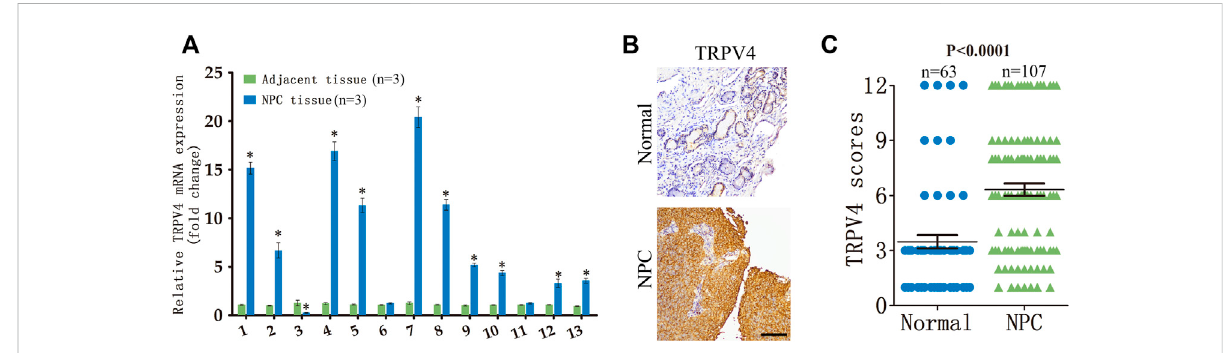
FIGURE 1 TRPV4expression inNPC tissues (A) Relative TRPV4mRNA levels in13 pairedtumorand normal nasopharyngealtissues fromNPC patients(n